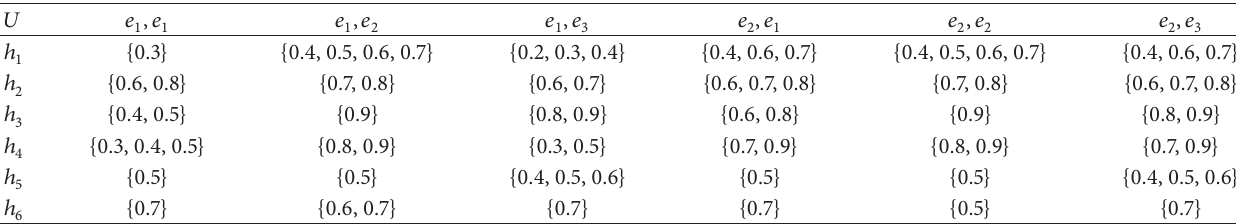
Table 5: The result of “OR” operation on